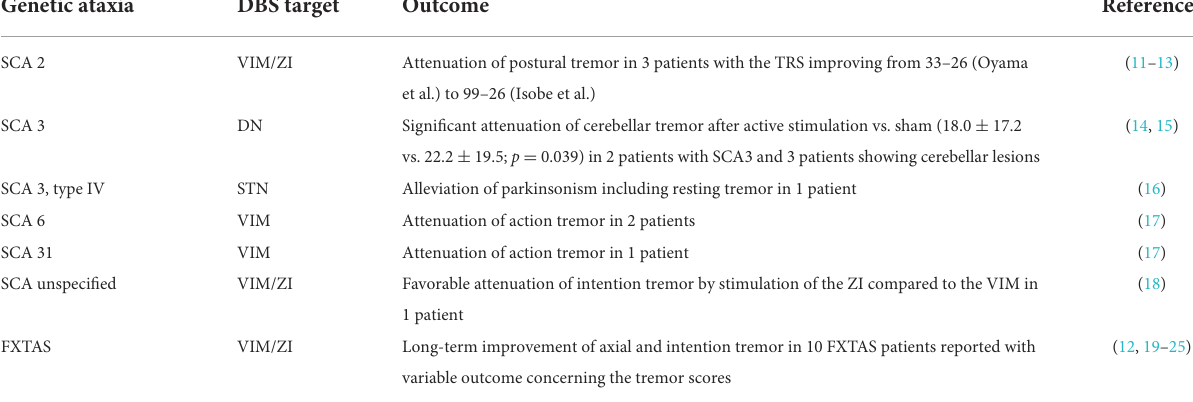
TABLE 1 DBS for the treatment of tremor in heredodegenerative ataxias. Genetic ataxia